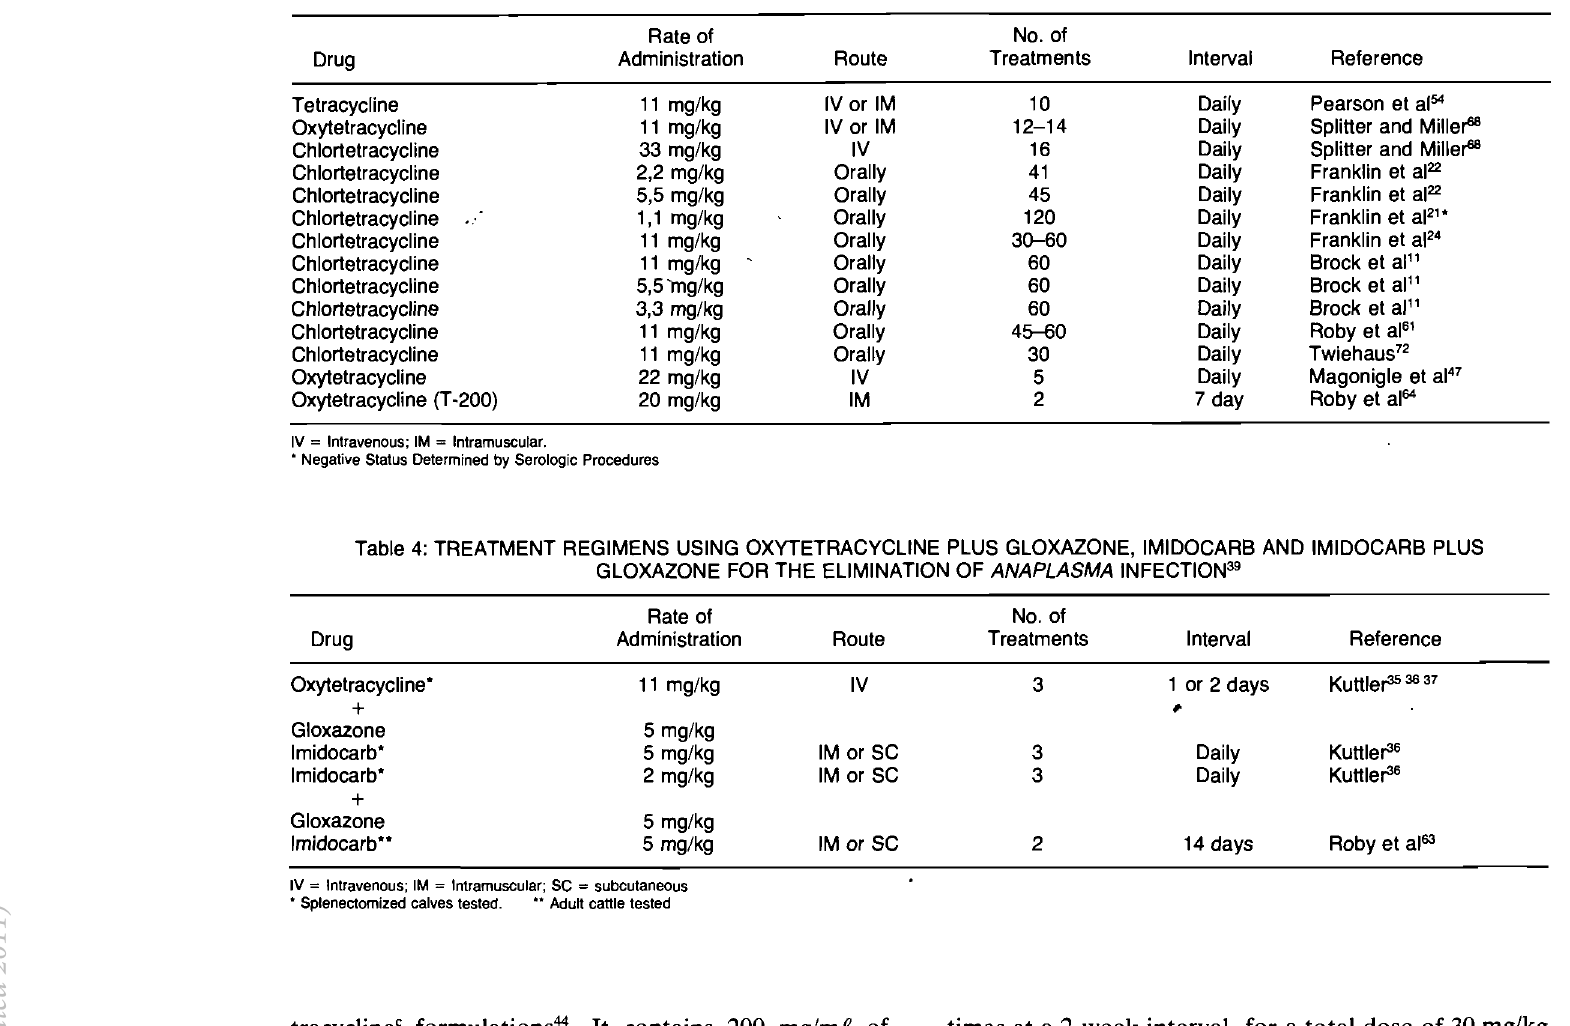
Table 3: SUCCESSFUL TREATMENT REGIMES FOR THE ELIMINATION OF ANAPLASMA INFECTION WITH THE TETRACYCLINE DRUGS39